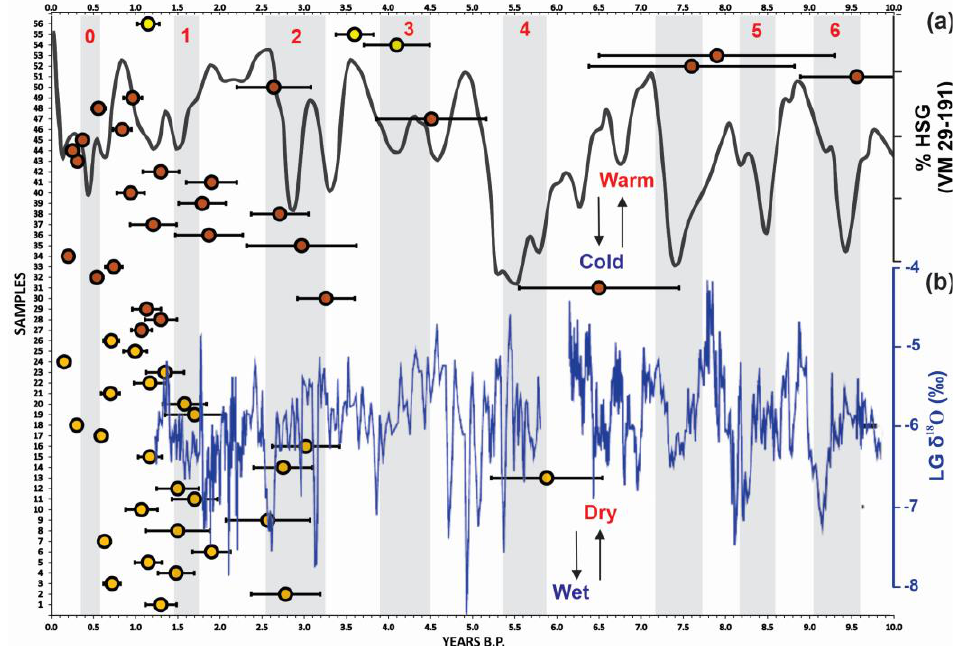
Figure 7. ( a ) Record of hematite-stained quartz grains (HSG) from the North Atlantic marine core VM 29-191 [15,56]. ( b ) Composite record of δ18O from stalagmites LG3 and LG11, Lapa Grande cave, central east of Brazil [79]. Dots correspond to ages obtained by OSL dating for materials from low river terraces [27,34,37,68,70] (Supplementary Materials). Source: Adapted from Bond et al. [15,54], Strikis et al. [79], Cheng et al. [80], and Zielhofer et al. [81]. Additionally, when superimposed on the isotopic records of speleothems from the Lapa Grande cave located in the South Atlantic Convergence Zone (SACZ) corridor, most ages obtained for the depositional events present secular correlations linked to the periods